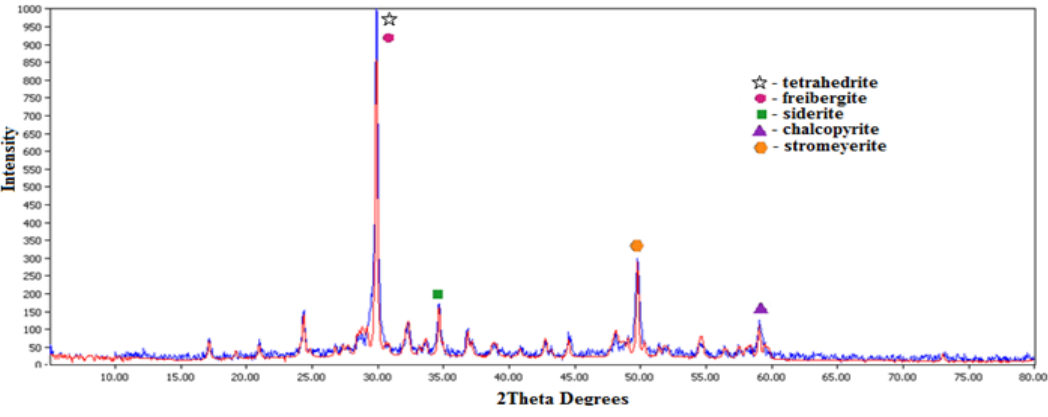
Fig. 1. XRD diffractogram of freibergite-tetrahedrite concentrate Minerals content of the polysulfide (freibergite- tetrahedrite-stromeyerite-chalcopyrite) concentrate Table 1. Minerals content of the polysulfide concentrate from Asgat ore